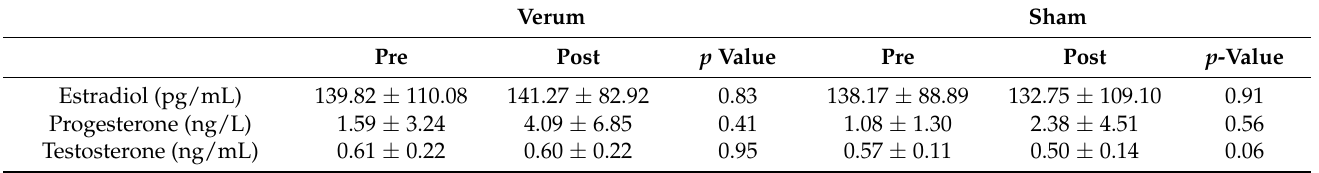
Table 2. Gonadal hormone levels before and after acupuncture treatments. All data are presented as mean ± standard deviation.